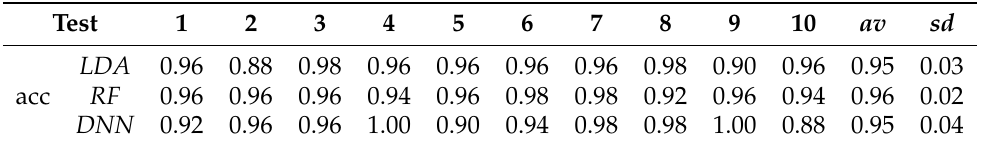
Table 2. Prediction accuracy for 10 validations of 50 feature samples (10 per class). LDA —Linear Discrimination Analysis, RF —Random Forest classifier, DNN —Deep Neural Network, av —mean accuracy, sd —standard deviation.